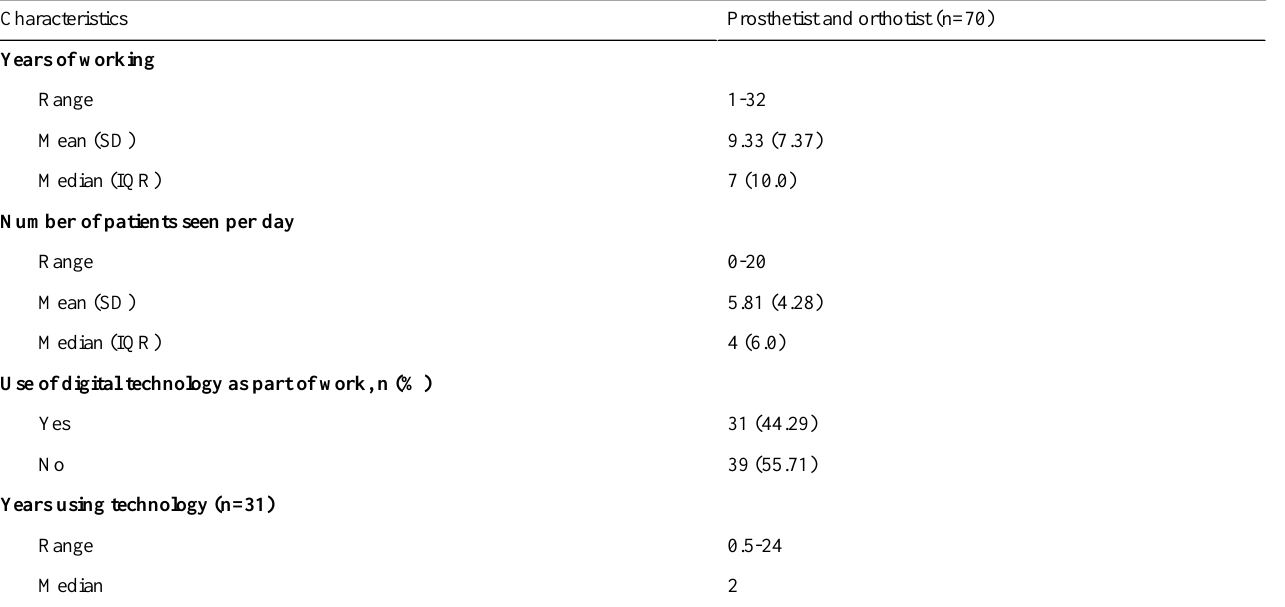
Table 3. Characteristics of prosthetist and orthotist